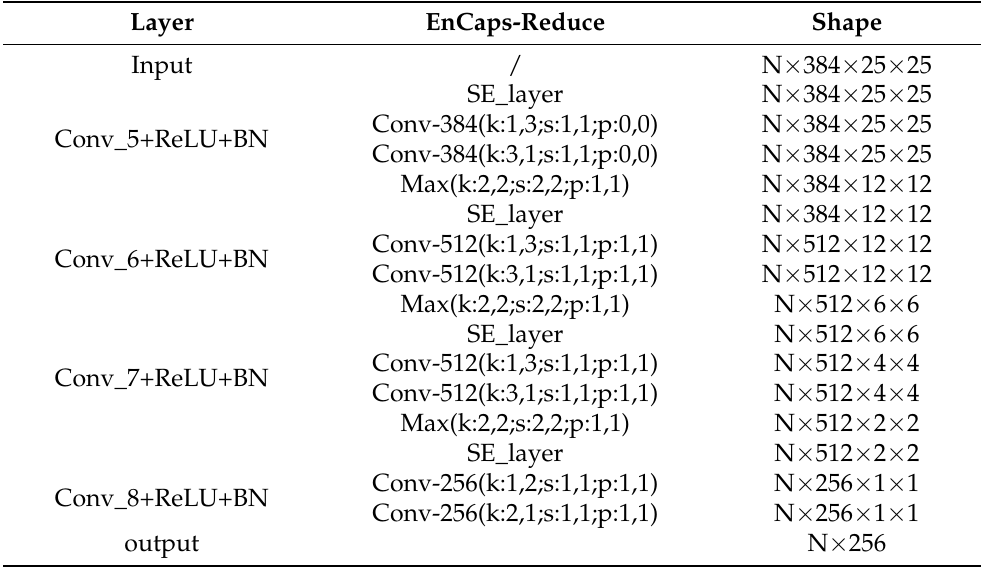
Table 1. The network structure of enhanced feature extraction model. ‘k’ represents ‘kernel’, ‘s’ represents ‘stride’, and ‘p’ represents ‘padding’.